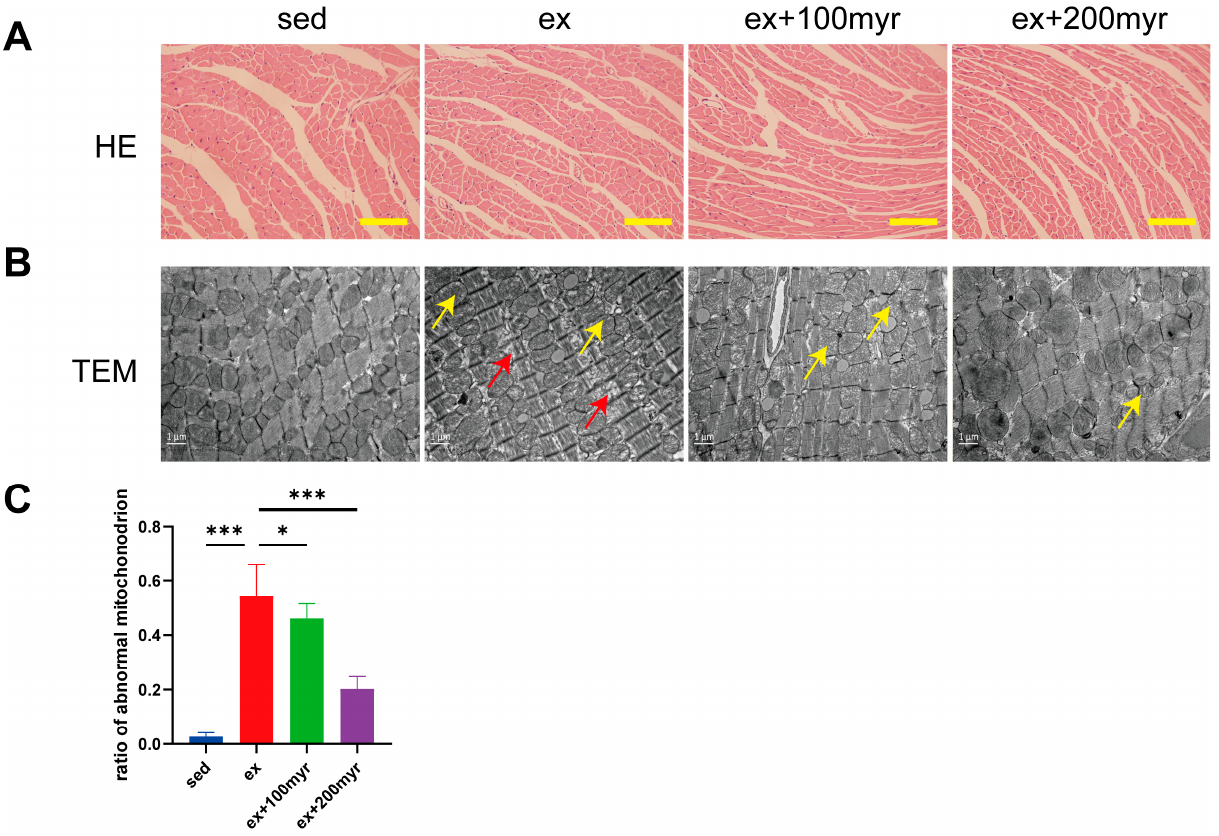
Figure 2. Effect of myricetin on myocardial pathology. ( A ) Representative HE staining results. Scale bar in the figure is 100 µ m; ( B ) representative transmission electron microscopy results; scale bar in the figure is 1 nm, magnification 15,000 × ; and ( C ) proportion of abnormal mitochondria. Yellow arrows indicate sparse arrangement of myocardial fibers, and red arrows indicate swollen and dissolved mitochondrial cristae. The data are presented as mean ± SD. * p < 0.05; *** p < 0.001. 3.3. Myricetin Decreased Myocardial Ischemia and Hypoxia Areas and Restored CX43 Content after HIE